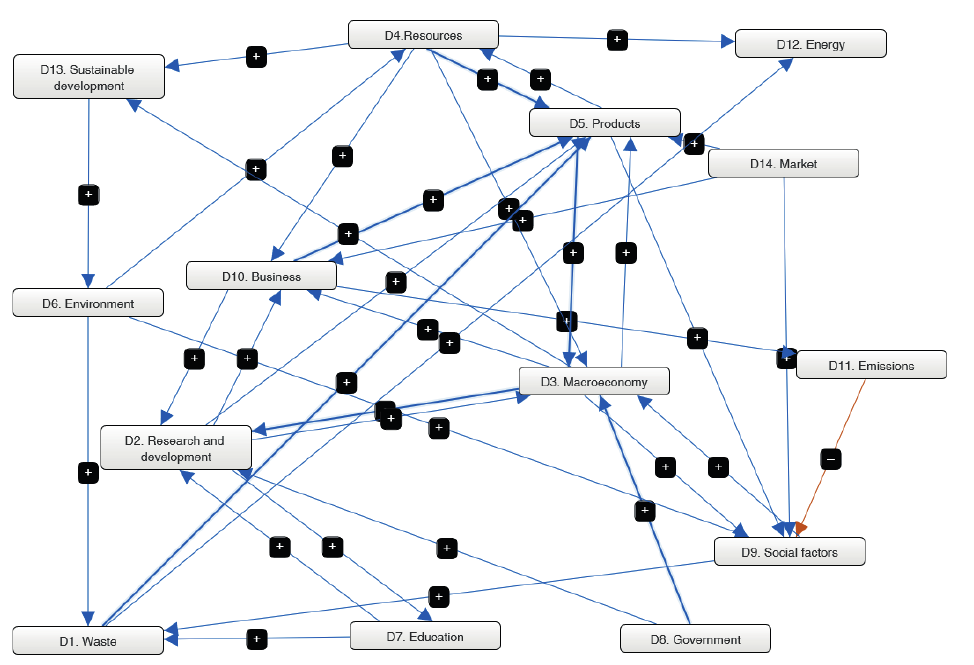
Fig. 3. Bioeconomy fuzzy cognitive